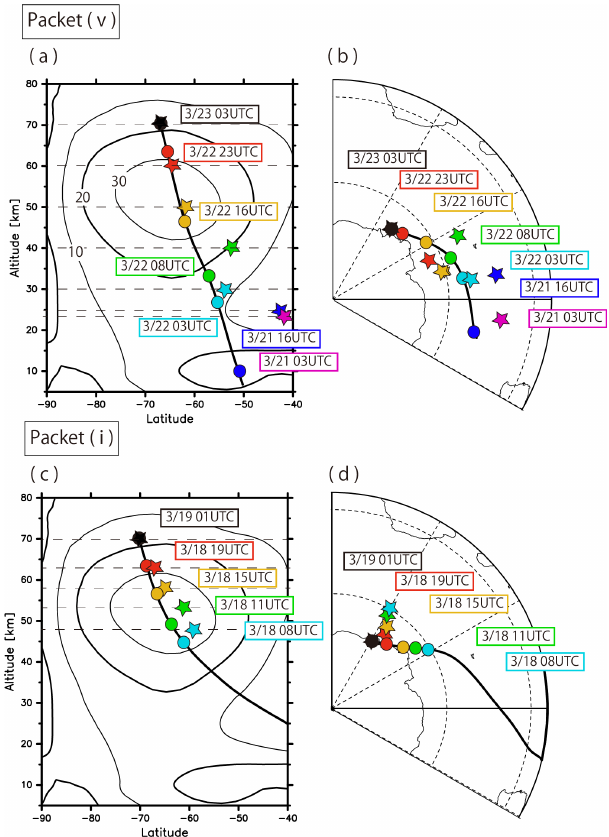
Figure 13. The ray path of (a, b) the packet (v) simulated by NICAM and (c, d) the packet (i) using the idealized ray tracing method (black thick line, colored circles) and the manual wave packet tracing method (colored star marks) in (a, c) the latitude– height cross section and (b, d) the horizontal map. The contours in (a, c) denote background zonal wind components averaged in the zonal direction and for the period from 17 to 23 March.